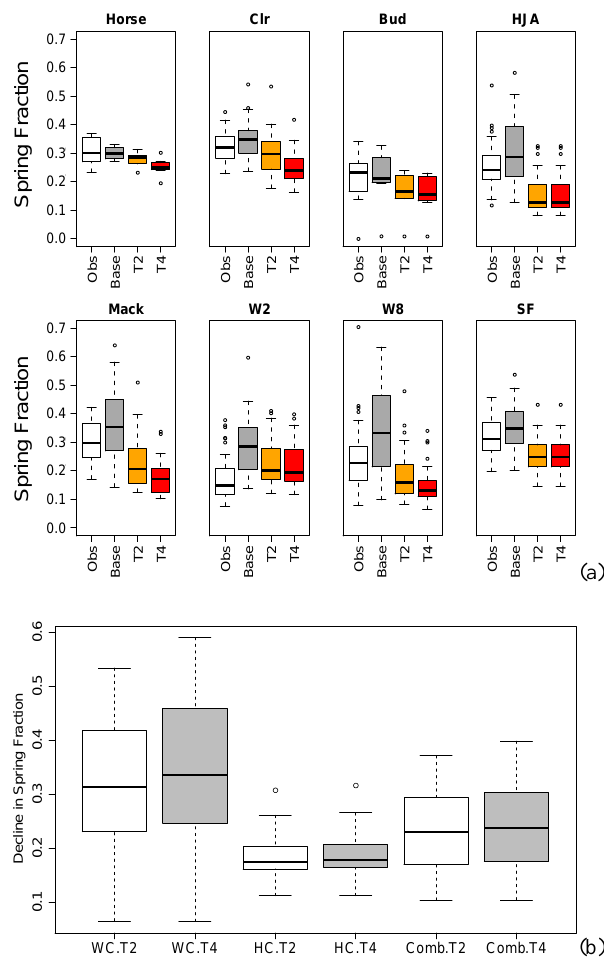
Fig. 7. (a) Variation in spring fraction of annual flow for mod- eled (white) and observed (gray) with historic climate (WY) and modeled results for a 2 ◦ C (orange) and 4 ◦ C (red) warming sce- nario. Results are shown for a single acceptable parameter set and for all years with observed/modeled streamflow (available water years for each watershed are listed in evaluation column of Ta- ble 4). (b) Change in modeled spring fraction of annual flow for 2 ◦ C (white) and 4 ◦ C (gray) warming scenarios in SF run as all WC, as all HC, and SF comprised of both HC and